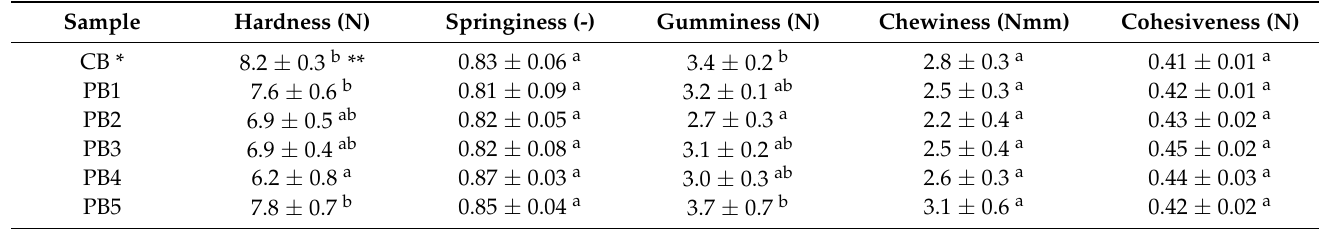
Table 3. Texture parameters and moisture of crumb for control and enriched